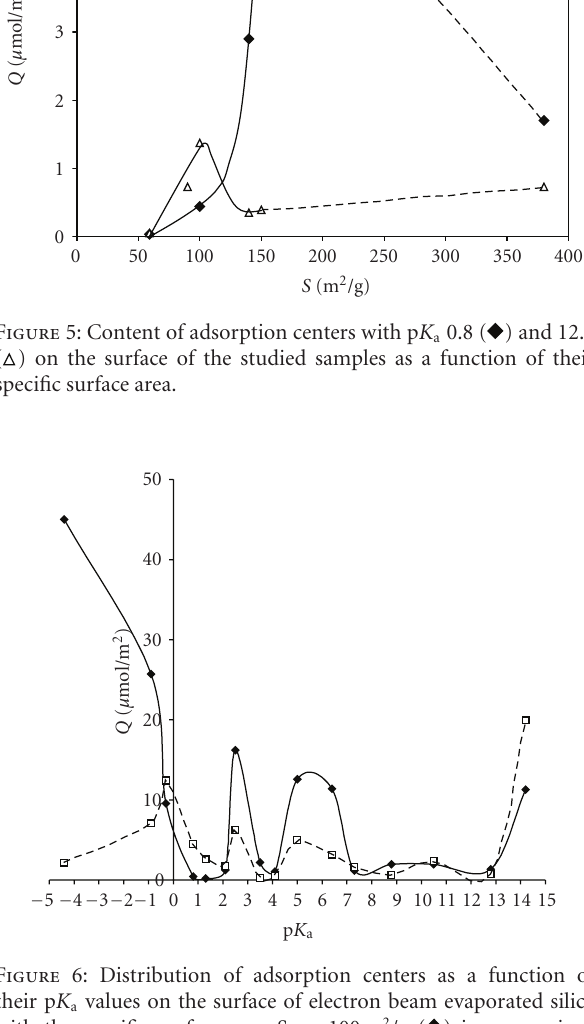
Figure 4: Content of adsorption centers with p K a –4.4 ( ), − 0.9 ( ) 2.5 ( ), and 8.8 ( ∗ ) on the surface of the studied samples as a function of their specific surface area.